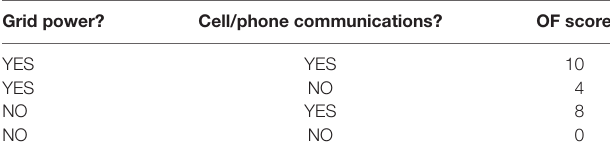
TaBle 5 | Opportunistic factors (OF) scoring